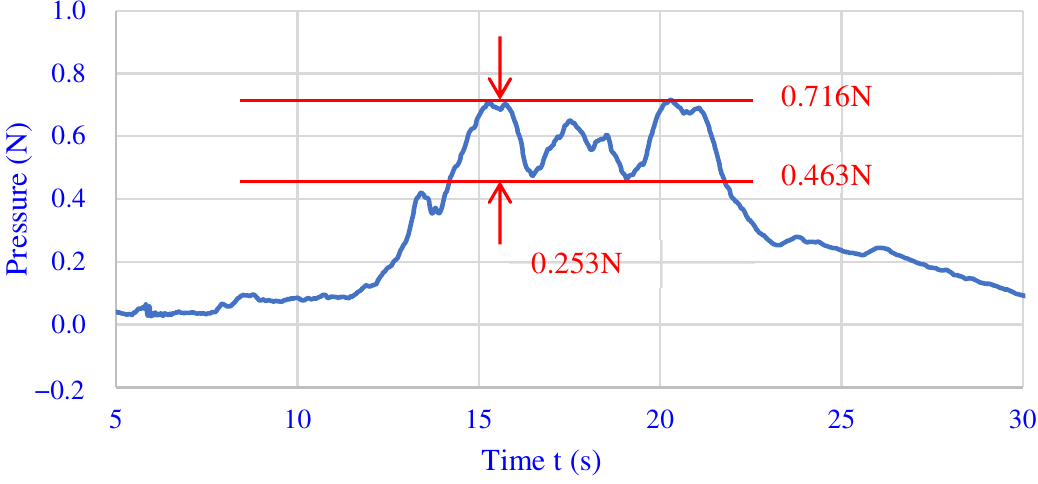
Figure 9. The measured results of pressure at 0.2 mm from magnetic pole.